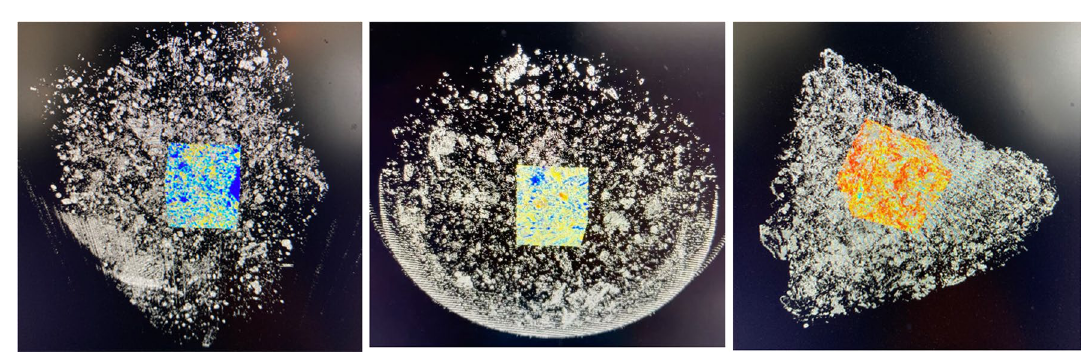
Fig. 3 Examples of how the 500 3 voxel analysis blocks were automatically selected chosen from the centre of each sample